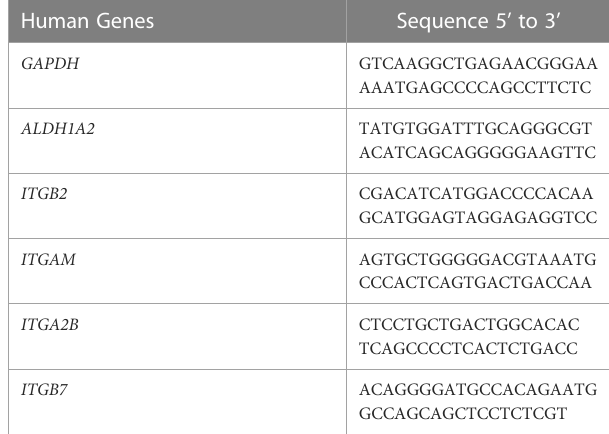
(Figure 1B, compare untreated WT and WT+FITC), but not from mice with only sensitization or only challenge (Figure S2).